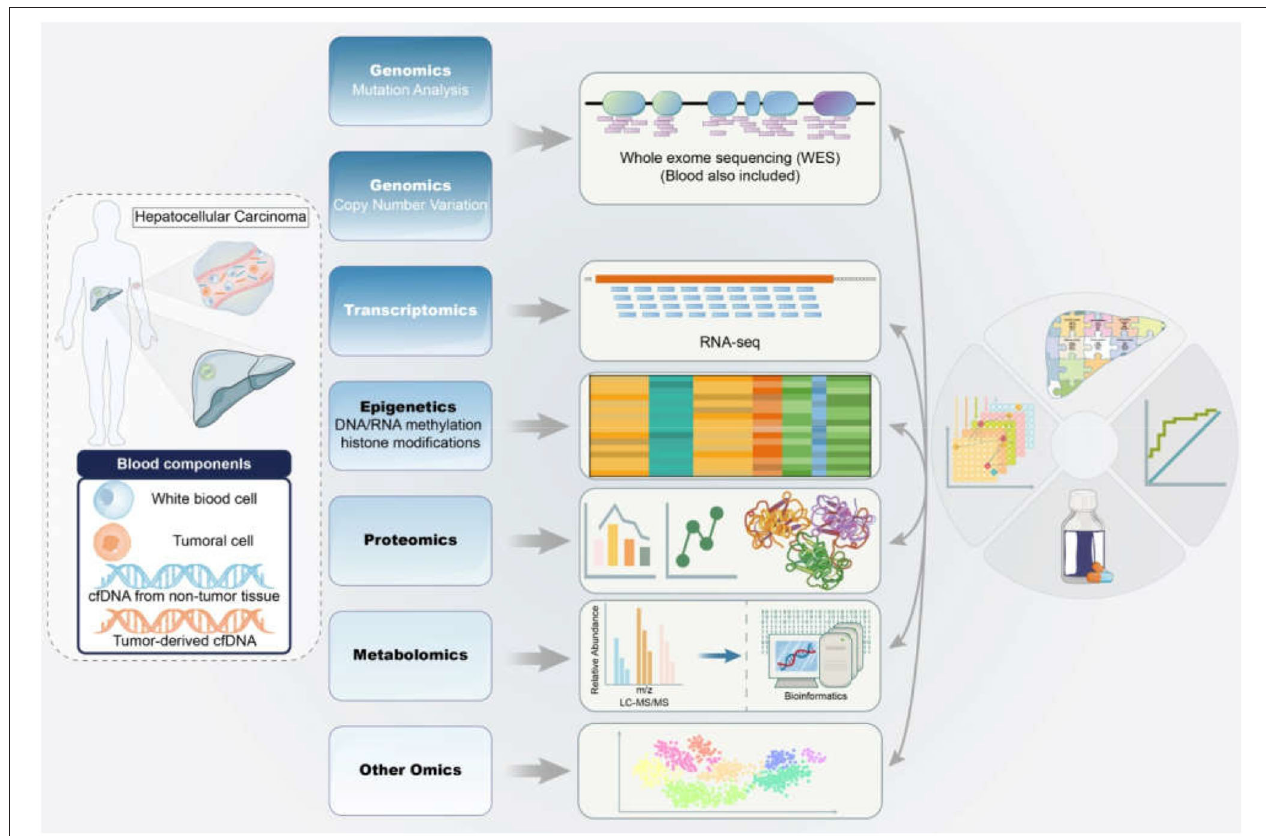
FIGURE 1 | Application of multi-omics in the diagnosis and therapy of HBV-associated HCC. The samples from HBV-associated HCC subjects were detected and analyzed by mitiomics technology including genomics, transcriptomics, epigenetics, proteomics, metabolomics and other omics to accurately promote biomarker-driven treatments and immunotherapies for HCC patients. HCC, hepatocellular carcinoma; HBV, hepatitis B virus; RNA-seq, RNA sequencing; LC-MS/MS, liquid chromatograph-mass spectrometer/mass